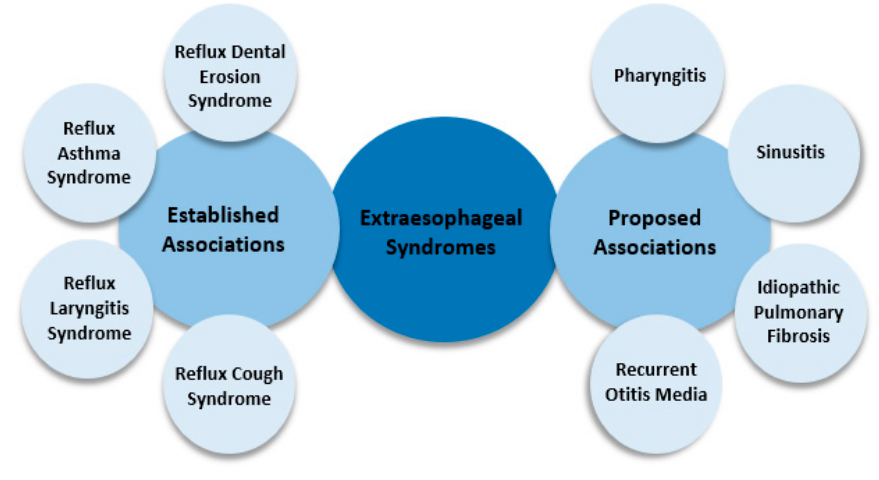
Figure 2. Extraesophageal syndromes of GERD [2].